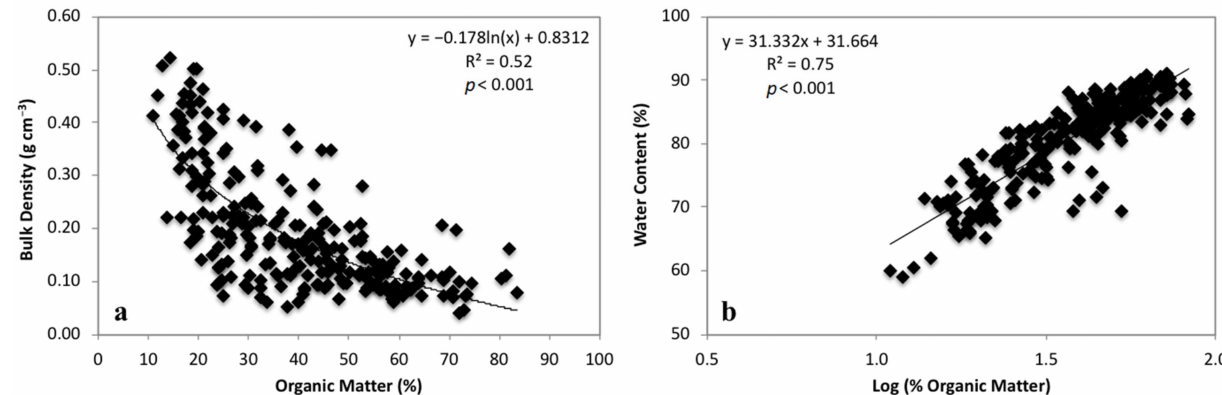
Figure 3. Relationships between ( a ) organic matter (%) and bulk density (g cm − 3 ); and ( b ) the log of percent organic matter versus percent water for soil cores taken at each subsite along the Nanticoke River.